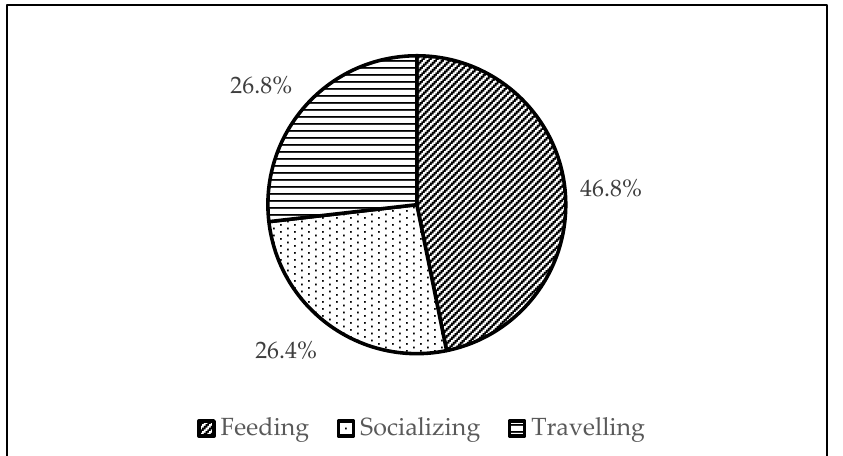
Figure 5. The behavioural events frequency percentage displayed by Irrawaddy dolphins in the bay.